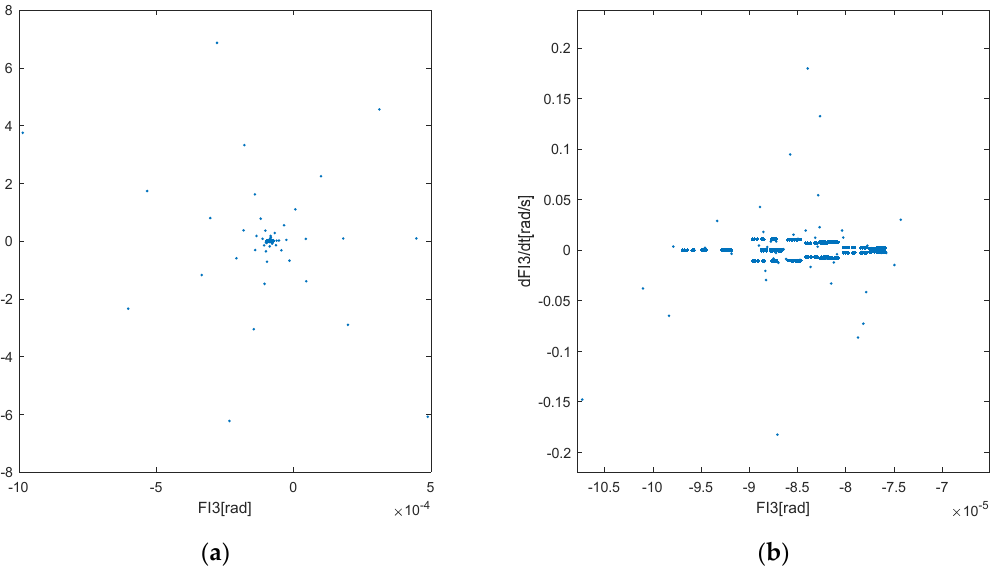
Figure 29. Poincaré Map of DOE3 for Figure 29. Poincar é Map of DOE3 for β ( b ) N = 5000.